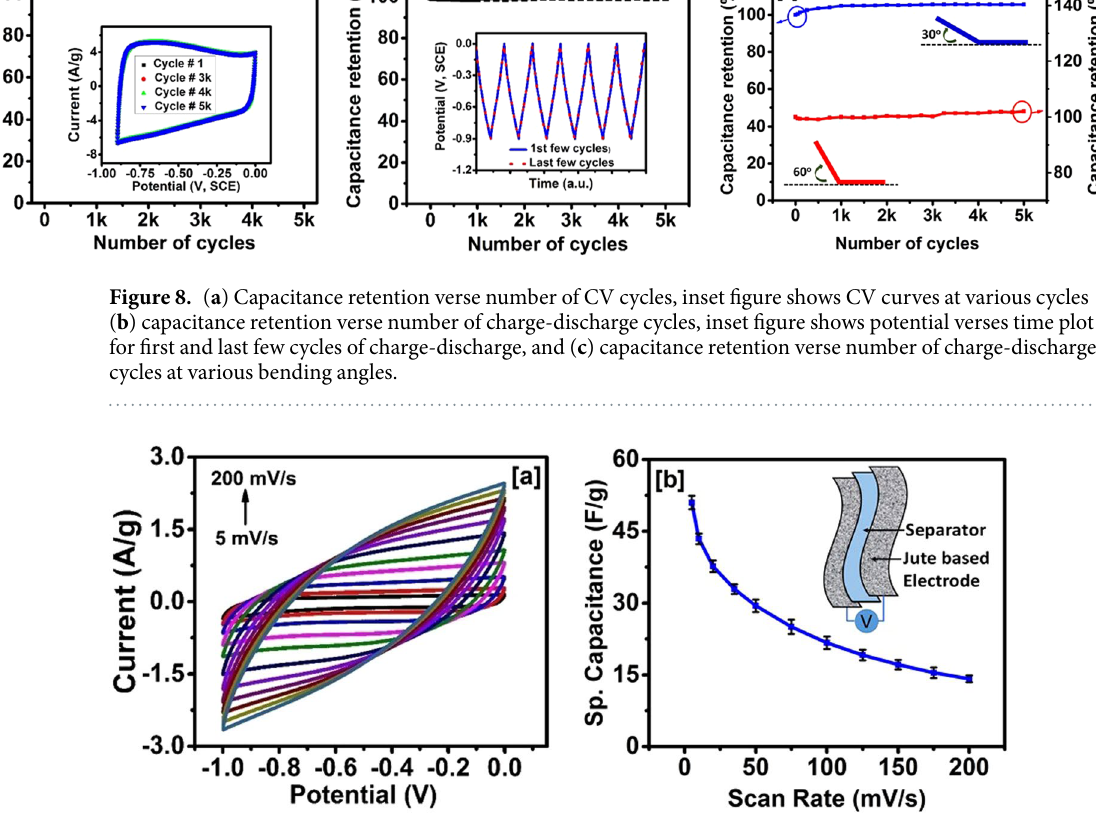
Figure 9. ( a ) CV curves at various scan rates and ( b ) variation of specific capacitance versus scan rate for the supercapacitor device made using carbonized jute, inset of figure ( b ) shows schematics of the supercapacitor